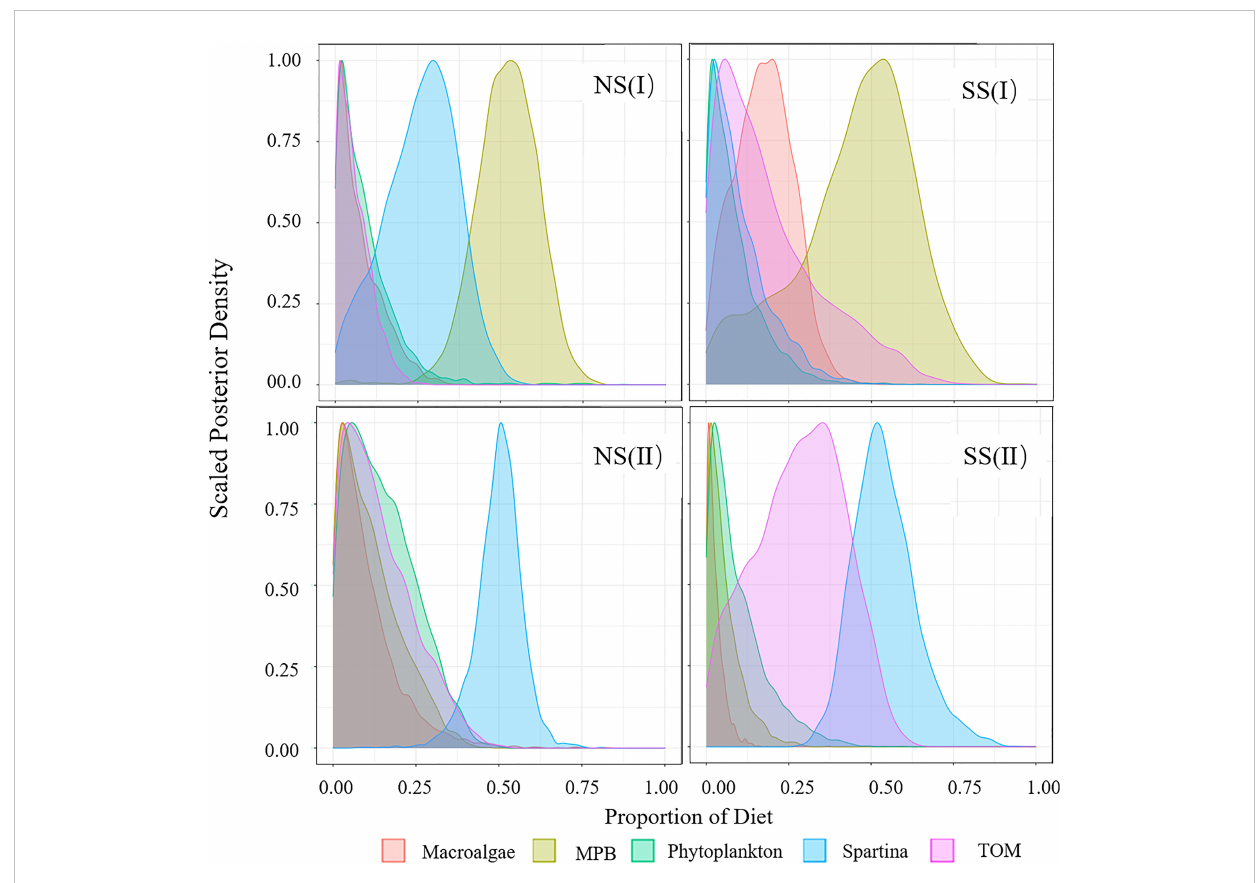
FIGURE 5 Diet Proportion of piscivorous fi sh. (I) Flood season; (II) Non- fl ood season; (NS) Northern shore; (SS) Southern